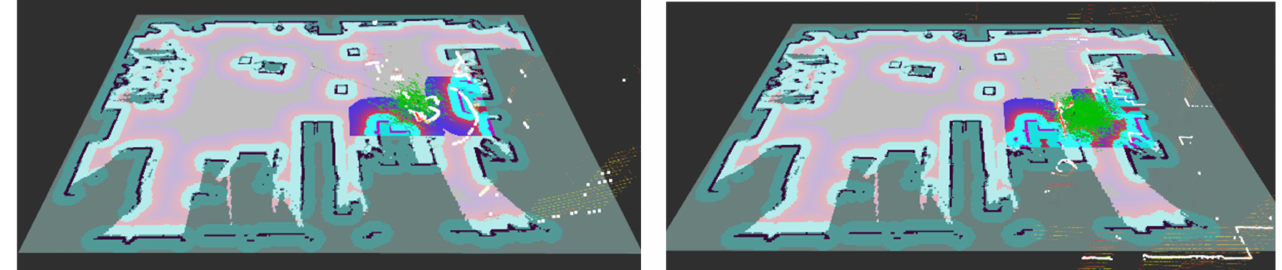
Figure 19. Point cloud correction before and after navigation map. The left figure shows before correction and the right figure shows after correction, the color shows the initial 3D laser point cloud data and the white color shows the 2D laser point cloud data obtained after